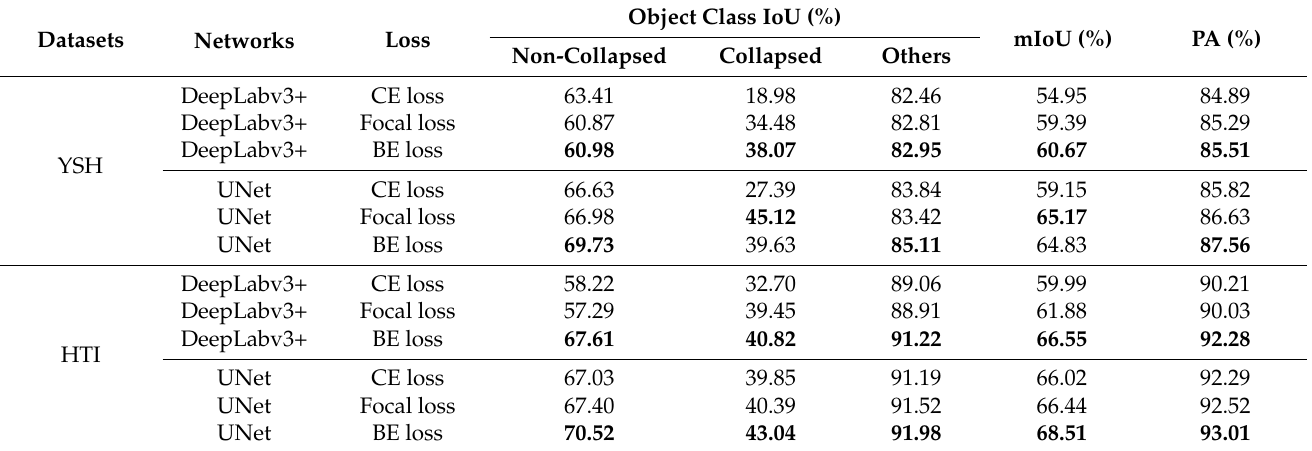
Table 3. Comparison and analysis of the effects of BE loss and other loss functions. The entries in bold denote the best on the corresponding